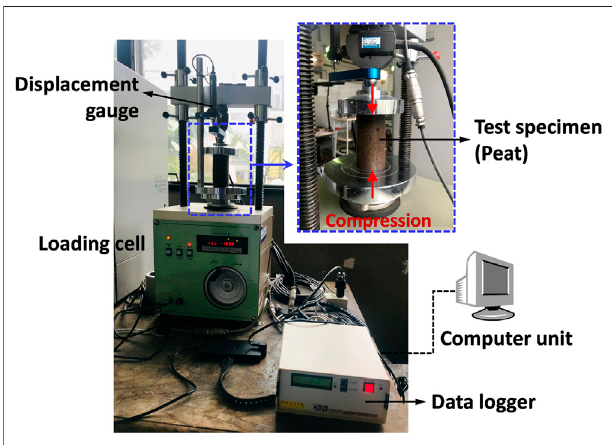
FIGURE 3 | Equipment set up: uncon fi ned compression